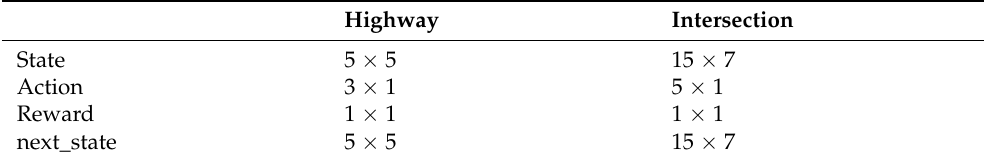
Table 1. The dimension of state space.